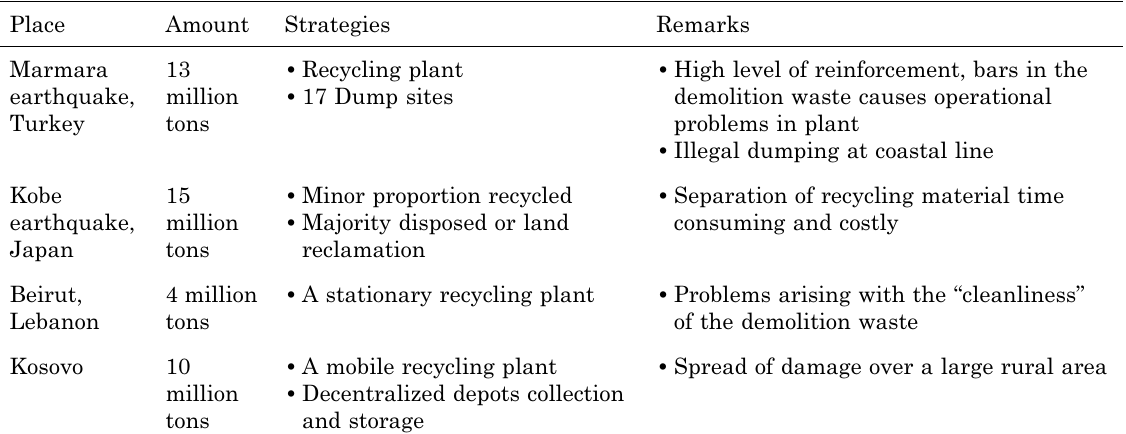
Source: Baycan and Petersen (2002); de Boer and Sanders